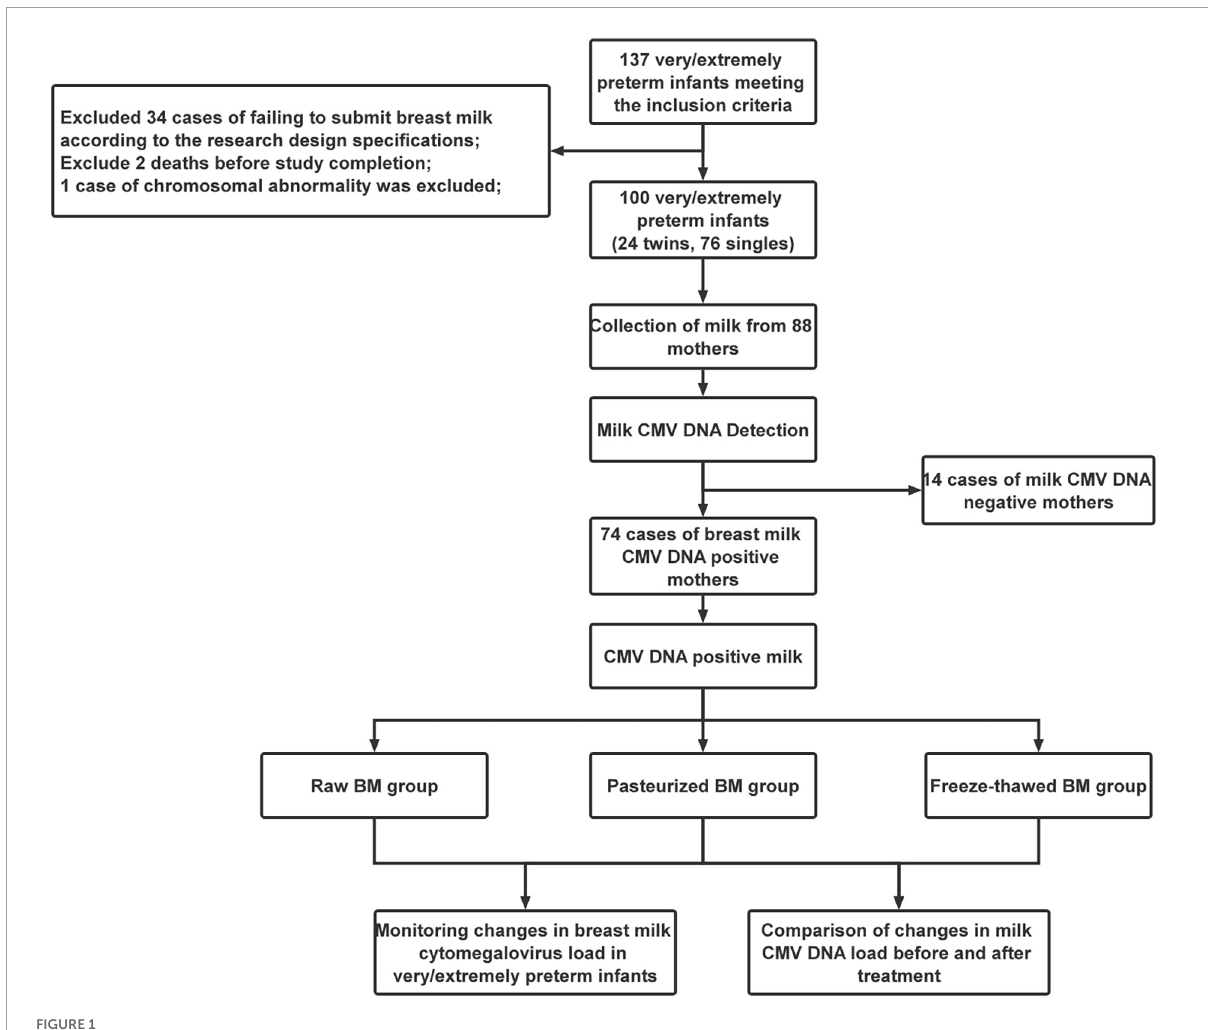
FIGURE1 Flow Chart of the